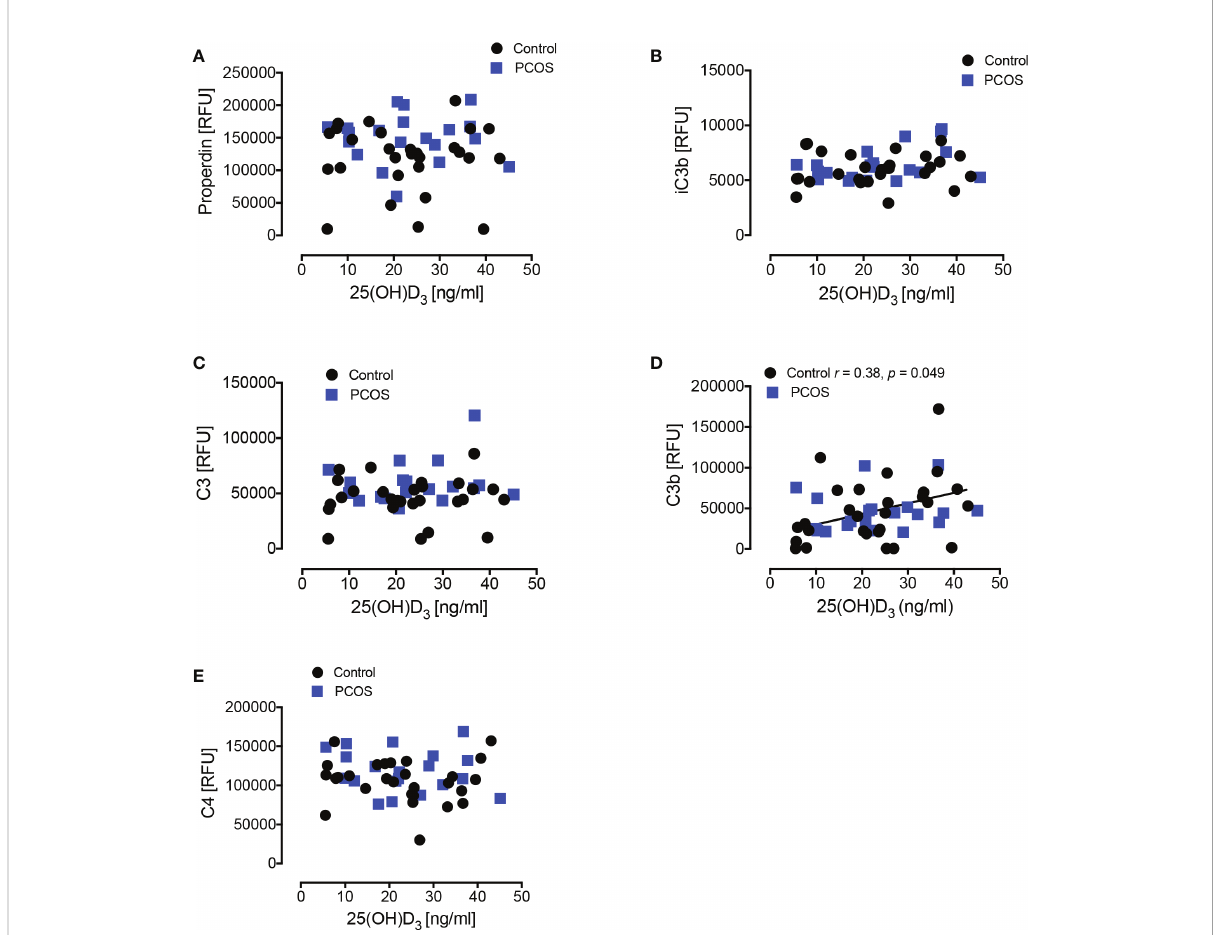
FIGURE 2 Correlations of complement pathway proteins with 25-hydroxy vitamin D 3 [25(OH)D 3 ]. Correlations of 25(OH)D 3 with properdin (A) , iC3b (B) , C3 (C) , C3b (D) , and C4 (E) in women with PCOS and control women are shown. Only in controls did C3b show a positive correlation with 25(OH) D 3. RFU, Relative Fluorescent